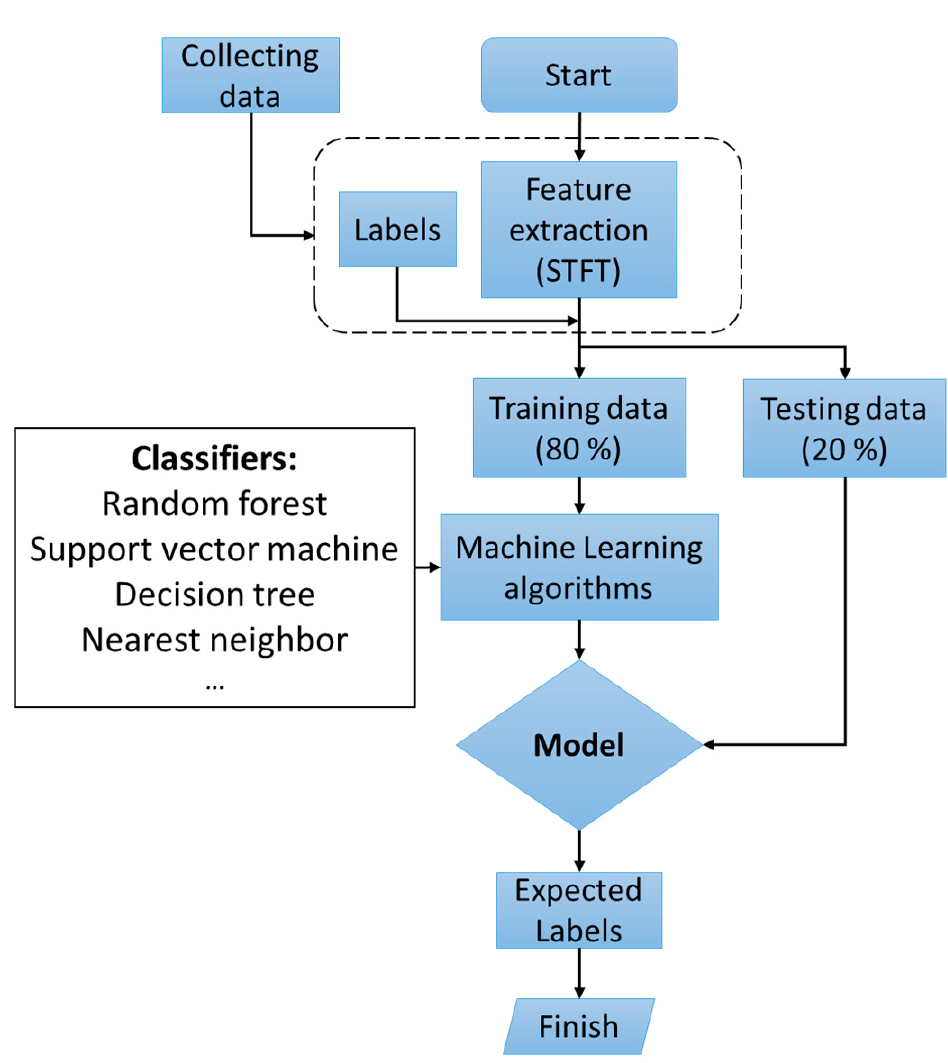
Figure 1. The flowchart of the proposed method for bolt-loosening detection.